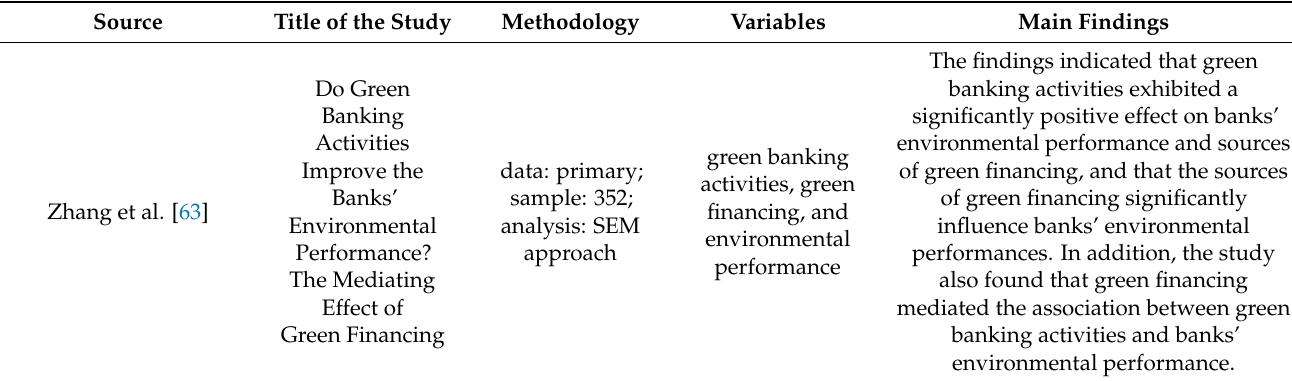
Table A1. Summary of recent empirical